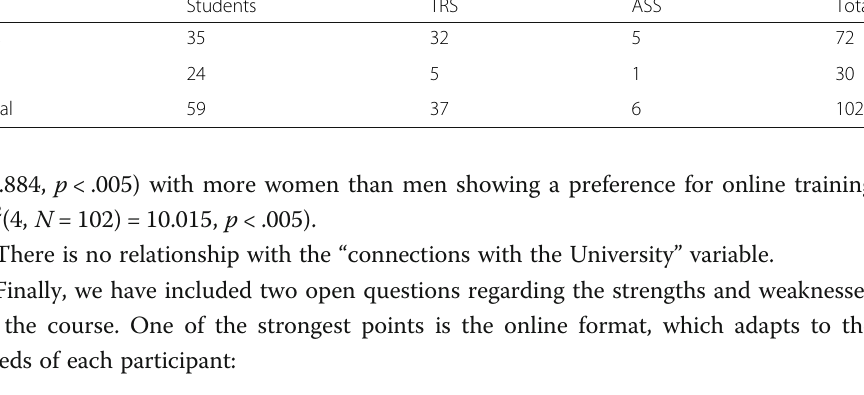
Table 3 Have you ever taken an online course before? Students TRS ASS Total Yes No Total